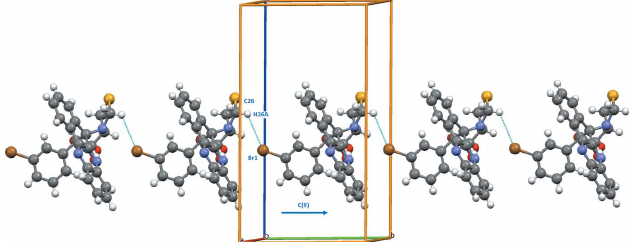
Figure 3 A C (9) chain motif formed through C—H (cid:3)(cid:3)(cid:3) Br interactions extending along the b -axis direction. Hydrogen bonds are shown as dashed lines.